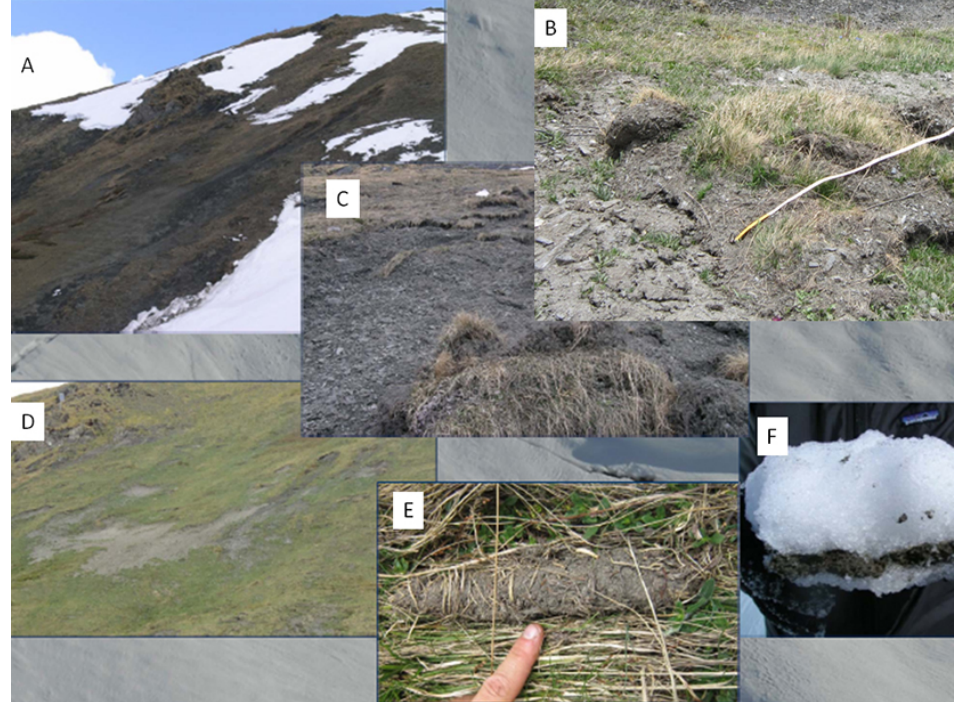
Figure 2. Evidence of erosion features in the avalanche release area. (A) view of the avalanche release area just after the snowmelt (RA); (B) a shallow landslide that occurred in winter time, under snow cover, probably as a consequence of snow glide movements; (C) zoom on soil erosion and shallow landslides in RA; (D) view of eroded surface in the summer season; (E) soil “roll” including vegetation residuals, visible after snowmelt, probably due to snow gliding; (F) soil layer included in the snow bottom layer during spring time (photos: E. Ceaglio). Soil can undergo liquefaction processes when the soil water content increases. This may result in the layer found at the bottom of the snow pack observed in (F)